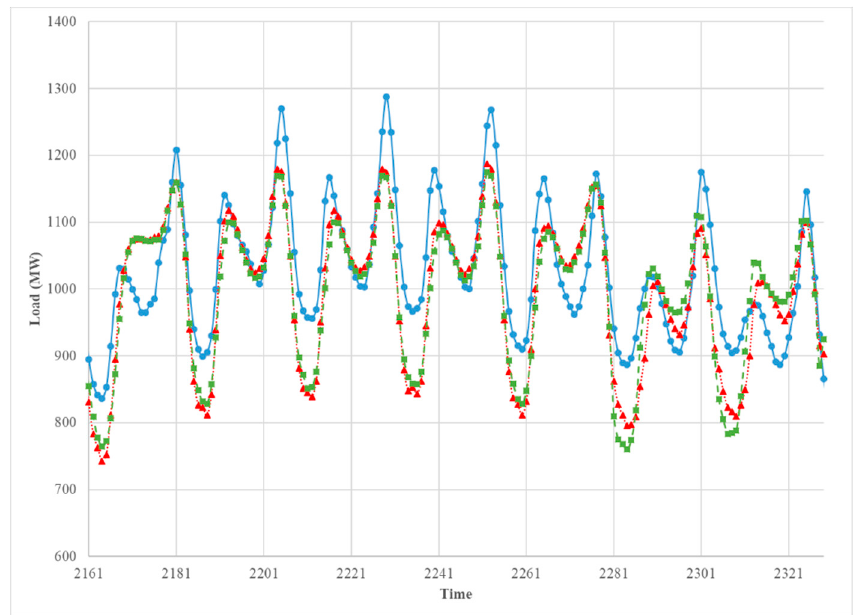
Figure 12. The comparison between the observed hourly load (blue solid), the predicted hourly load of Model 1 (red doted), and Model 2 (green dashed). 1 April 2013–7 April 2013.